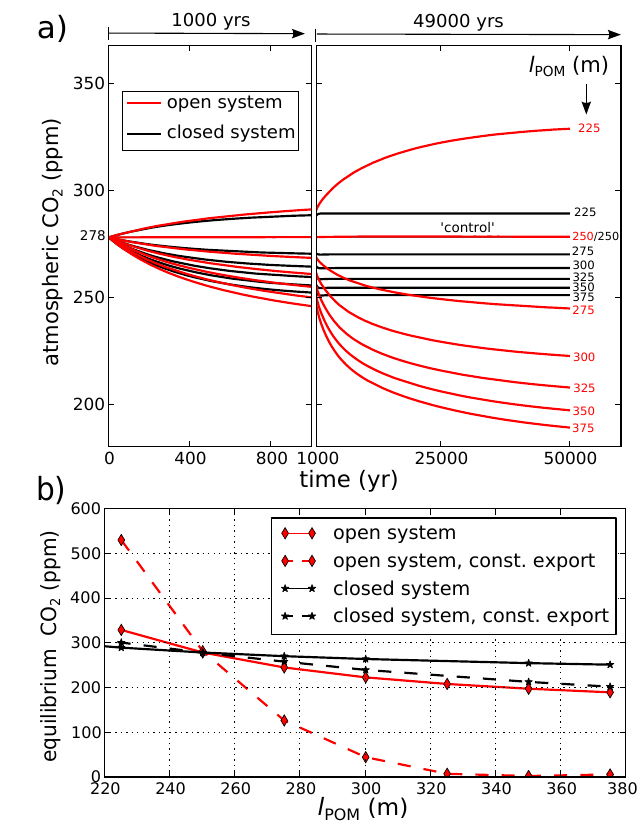
Figure 6. (a) Time evolution of atmospheric CO 2 as a result of instantaneous changes in the global POM remineralisation pro- files for the open system (red) and the closed system (black). The first 1000yr of the time axis are enlarged. (b) CO 2 for a set of POM remineralisation depths with prognostic (solid lines) and con- stant (dashed lines) export production. Note that the constant ex- port case does not equilibrate in the open system due to sustained weathering–burial imbalance. The corresponding values were cal- culated after 50kyr.